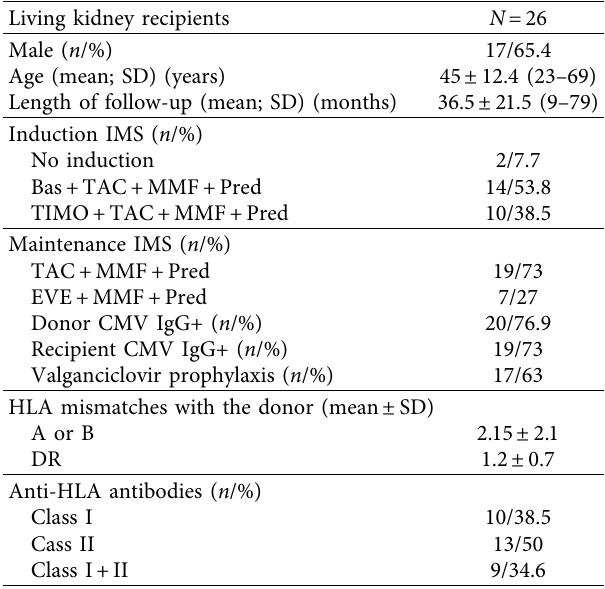
Table 3: Demographical and clinical data of living kidney trans- planted